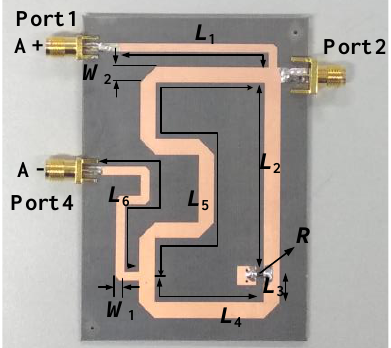
Figure 9. Photograph of the fabricated balun. Table 3. Dimensions of the prototype III (unit: mm; referring to Figure 9).